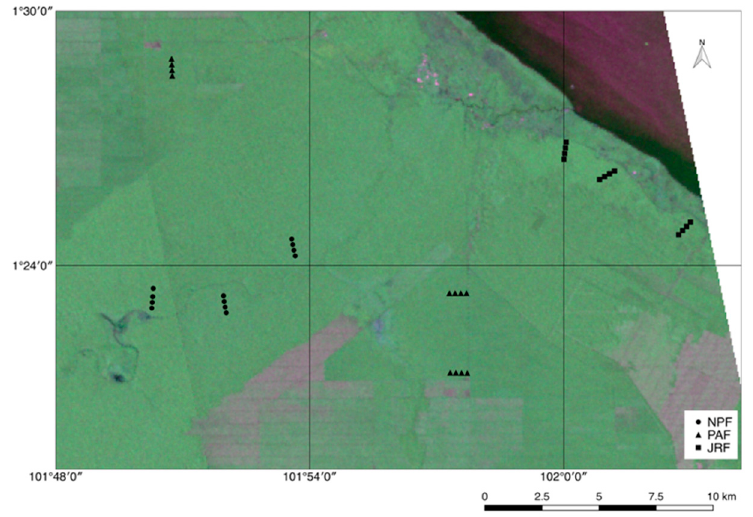
Figure 3. Three transects established on each land cover: natural peat swamp forests (NPF), planted acacia forests (PAF), and jungle rubber forests (JRF). Four survey points were on a 1 km each survey transect. The background is an RGB color composite image using different polarizations (R = HH; G = HV; B = VV).